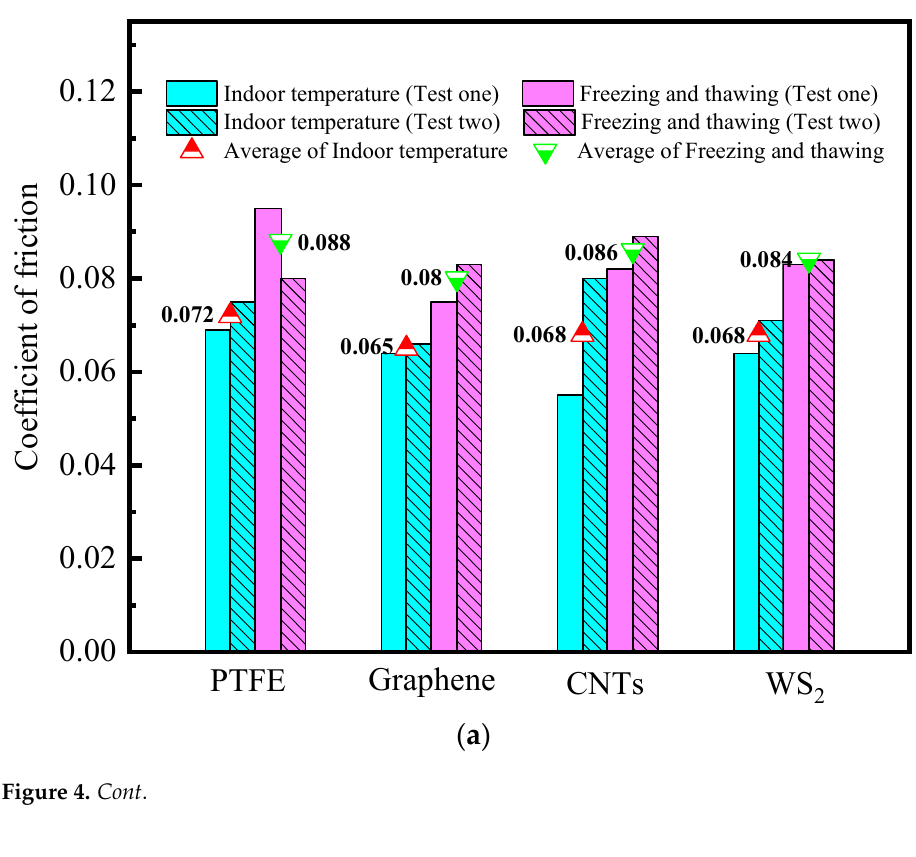
According to the optimal dosage, four kinds of grease are configured for the four-ball test, and the experimental results are shown in Figure 4.